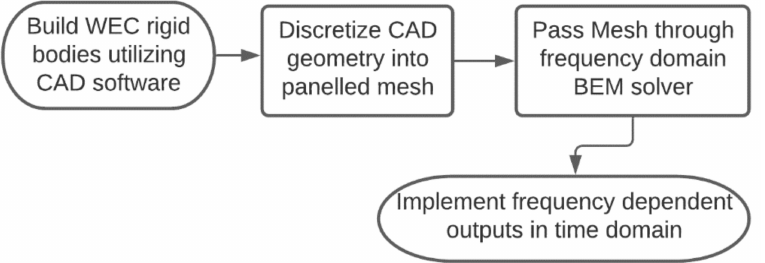
Figure 3. WEC numerical modelling procedure from creating a geometric build to implementating into a time-domain multibody dynamic